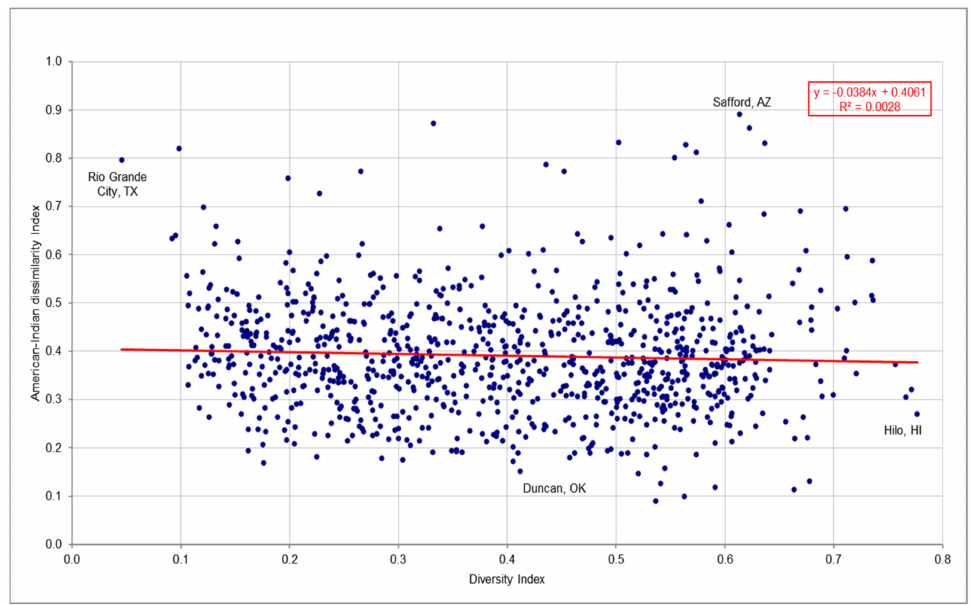
Figure 24. Relationship Between Diversity and Native American-White Dissimilarity.